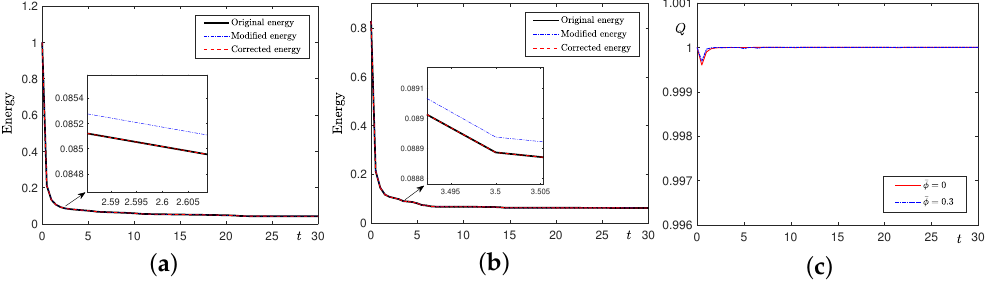
Figure 5. Evolutions of energy curves with respect to ¯ φ = 0 and 0.3 are shown in ( a , b ). Evolutions of Q n under different average concentrations are plotted in ( c